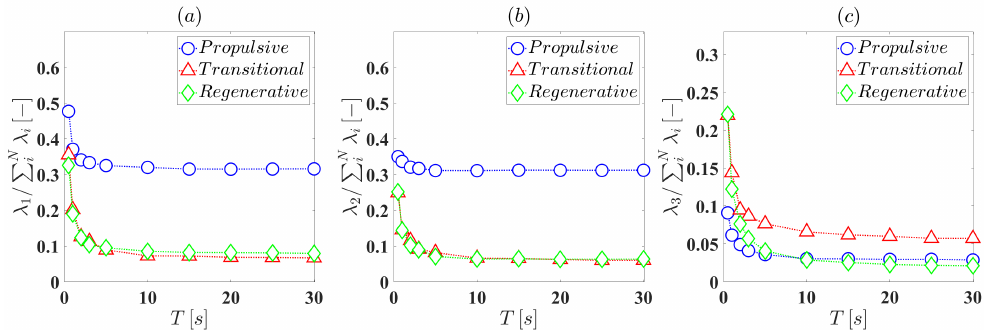
Figure 10. Convergence analysis of the eigenvalues for the POD decomposition for each operational condition. ( a ) First eigenvalue λ 1 ; ( b ) second eigenvalue λ 2 ; ( c ) third eigenvalue λ 3